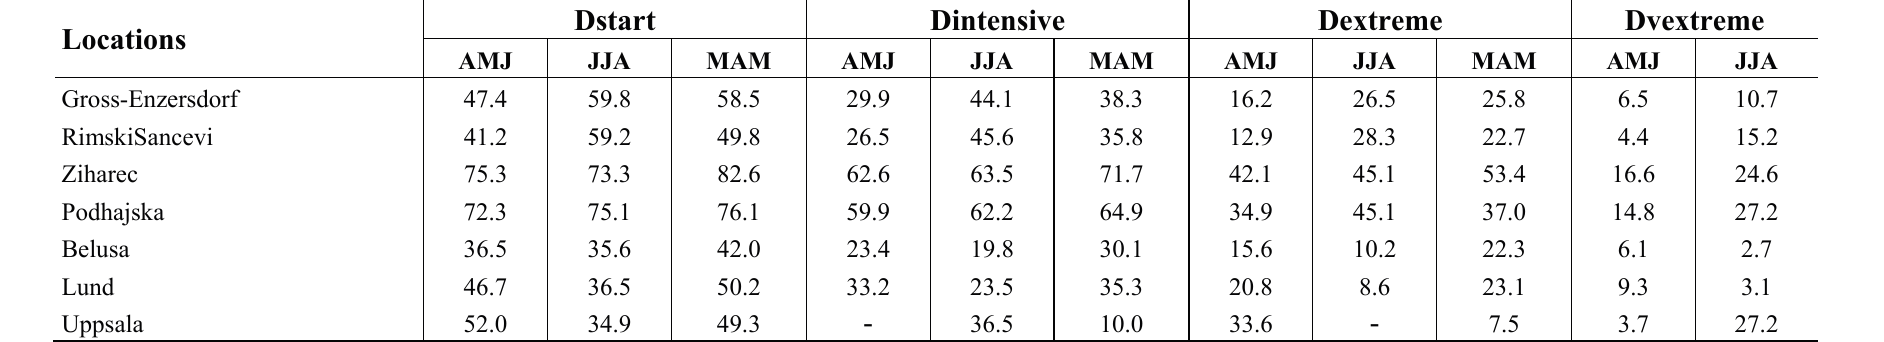
Table 4. Average number of dry days at the selected locations for the periods shown in Table